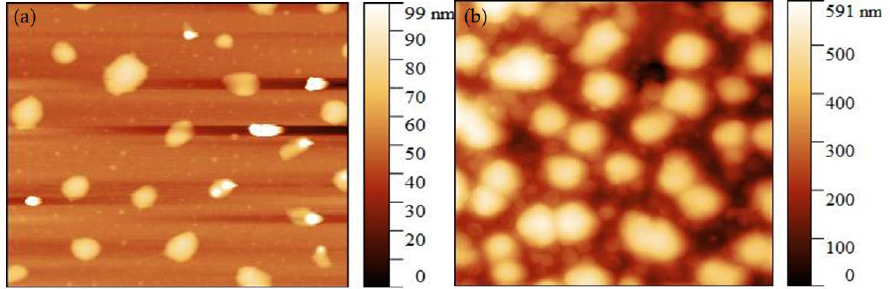
Figure 5 Atomic force microscope image of ( a ) CMOISW and ( b ) thermally cured OISW carbox- ymethylated OISW.